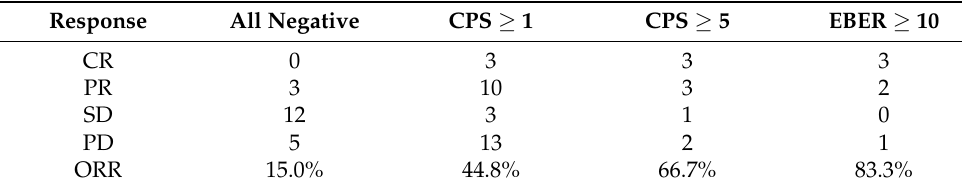
Table 3. Outcomes of patients with different cut-off levels of PD-L1 CPS.